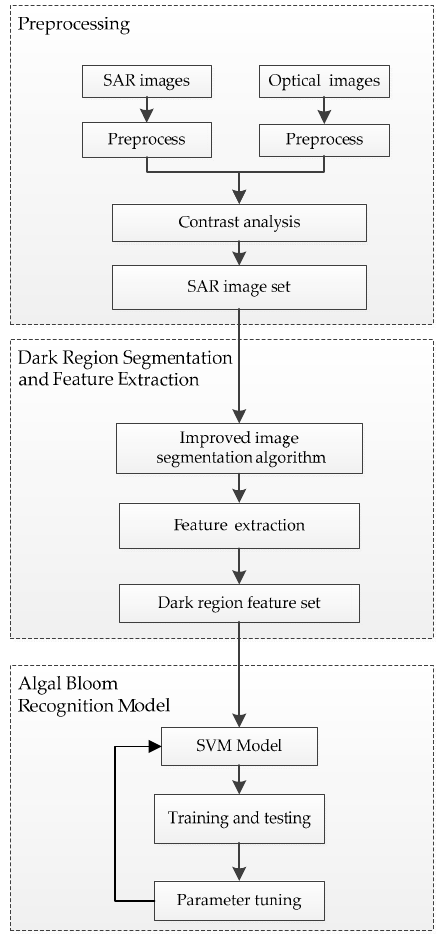
Figure 8. Flowchart of algal bloom recognition.